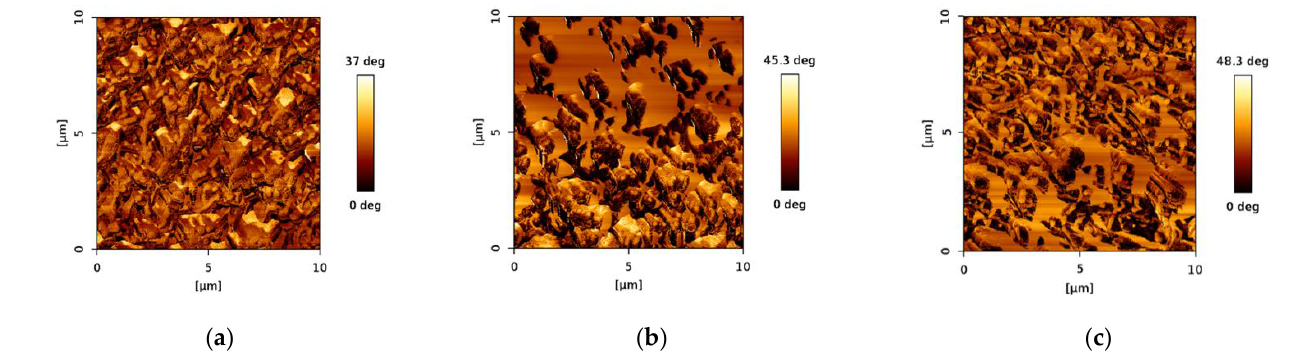
Figure 5. AFM micrographs of three-dimensional topology in 10 × 10 µm scale of ( a ) bare PES membrane, ( b ) chitosan functionalized PES membrane before nanoMIP immobilization, and ( c ) chitosan functionalized PES membrane after nanoMIP immobilization.